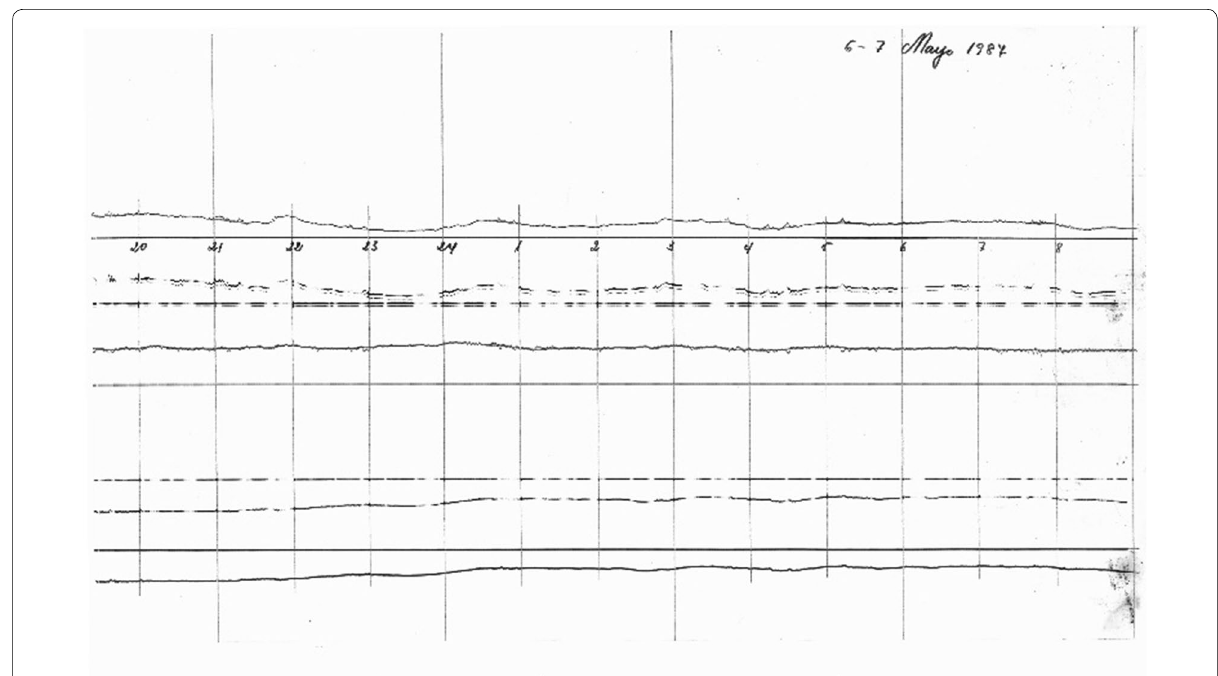
Fig. 13 Copy of a fragment of a magnetogram from the Ebro Observatory corresponding to the end of 6 May, 1987, and the beginning of the next day (7 May, 1987)